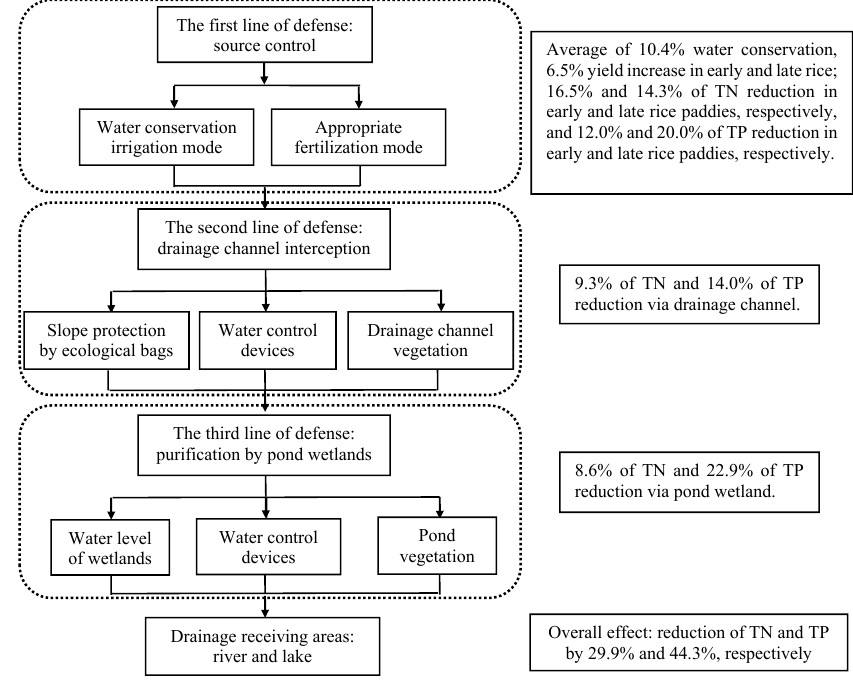
Figure 4. Overall reduction of pollutants by the Poyang Lake agricultural non-point source pollution integrated ecological restoration technique.